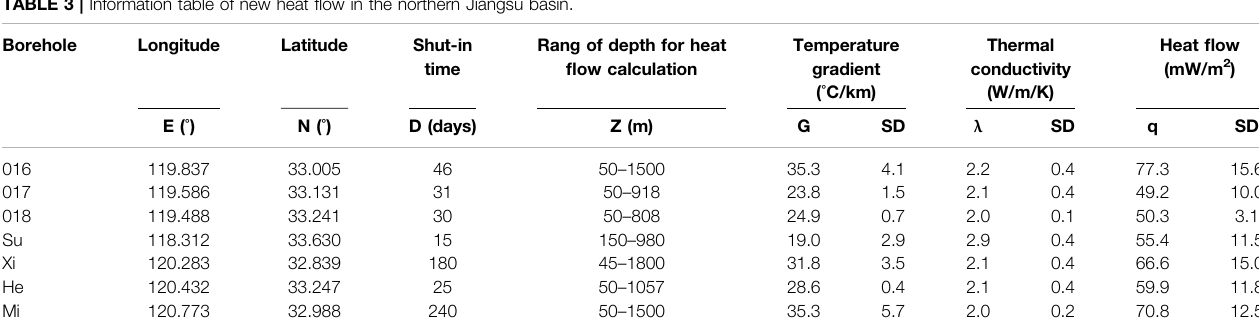
TABLE 3 | Information table of new heat fl ow in the northern Jiangsu basin.